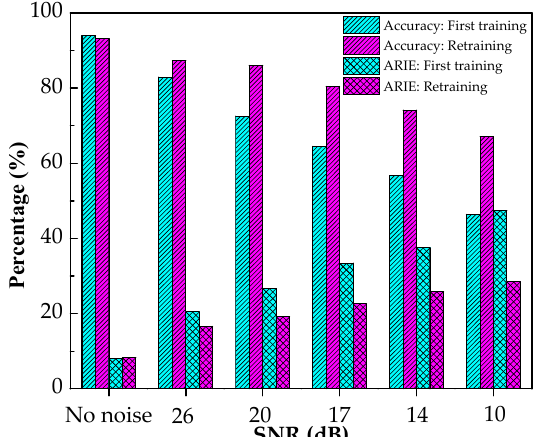
Figure 11. Influence of environmental noise on the proposed method.